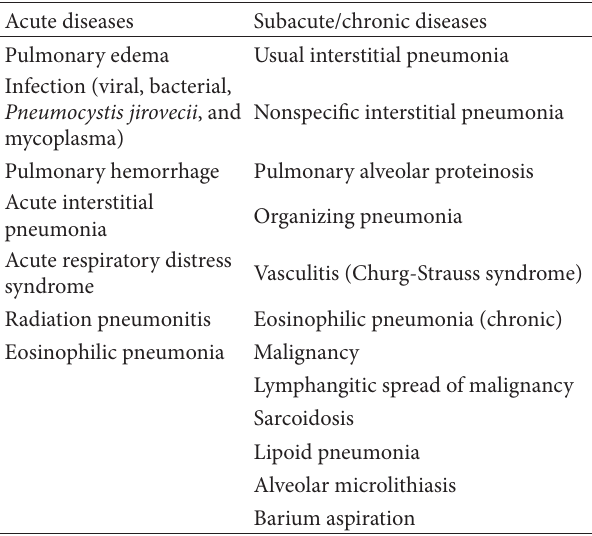
Table 1: Differential diagnosis of crazy paving on CT imaging, adapted from De Wever et al.